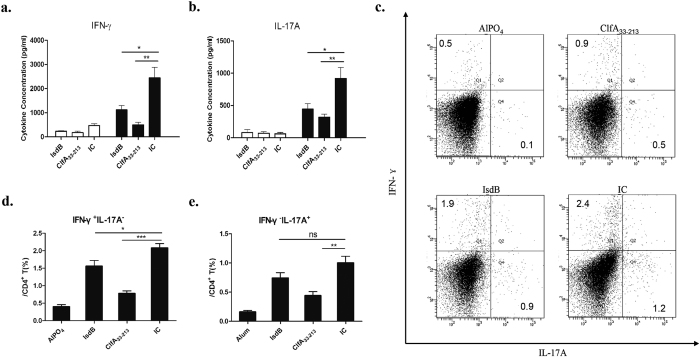
Cytokine responses and CD4+ T cell polarization of splenocytes.One week following the last booster, the splenocytes from vaccinated mice (n = 6) were incubated with corresponding antigen proteins (10 μg/mL) for 5 days. The supernatants were harvested, and the cytokine levels of (a) IFN-γ, (b) IL-17A were determined. The means ± SEM were shown. Empty boxes representative without stimulation, black boxes representative splenocytes stimulate with corresponding proteins. Asterisks indicate significant differences. (*P < 0.05, **P < 0.01). (c) After 5 days incubation, the splenocytes were stimulated with PMA/ionomycin and Golgistop for 6 h. Cells were stained for CD3, CD4, IFN-γ, or IL-17, and was analysed by flow cytometry. The responses of Th1 (d) and Th17 (e) of the AlPO4 group and recombinant vaccine immunised groups were presented as column bar graph and shown as means ± SEM. Results represent three independent experiments (*P < 0.05, **P < 0.01, ***P < 0.001).